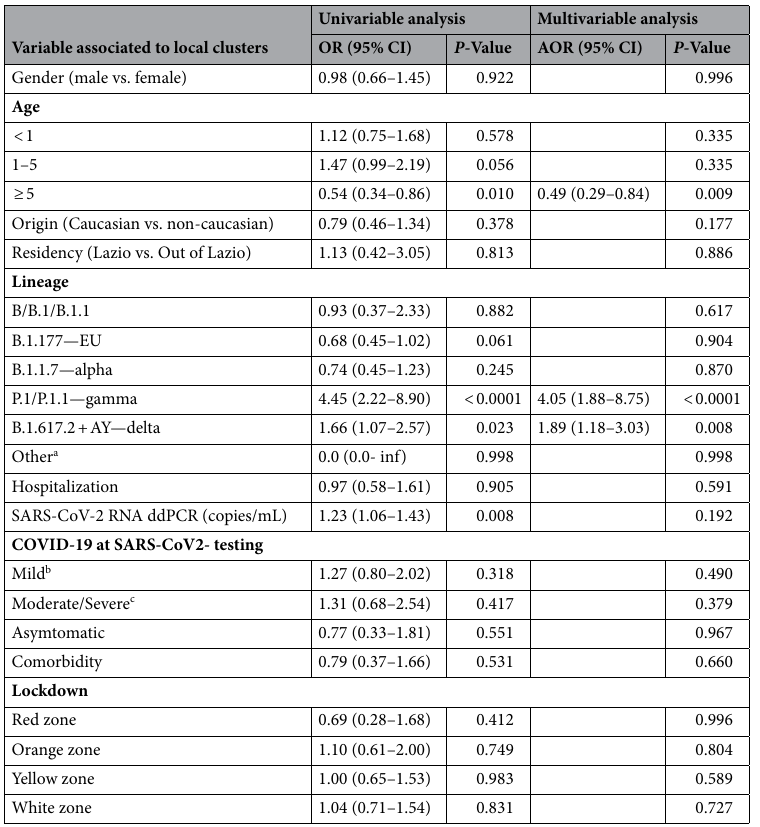
Table 2. Multivariable logistic regression analysis of factors associated with local transmission clusters. OR odds ratio, AOR adjusted odds ratio, CI confidence interval. a Includes: B.1.160 ( n = 14), B.1.221 ( n = 2); B.1.258 ( n = 4), B.1.351 ( n = 1), B.1.36 ( n = 2), B.1.525 ( n = 2), B.1.398 ( n = 1), B.1.416 ( n = 1), C.36.3 ( n = 1). be Including: symptoms of upper respiratory airways (rinhitis, pharyngo-adenitis, laryngitis) and/or gastrointestinal symptoms. c Including: symptoms of lower respiratory airways (pneumonia, bronchitis and bronchiolitis) with or without gastrointestinal